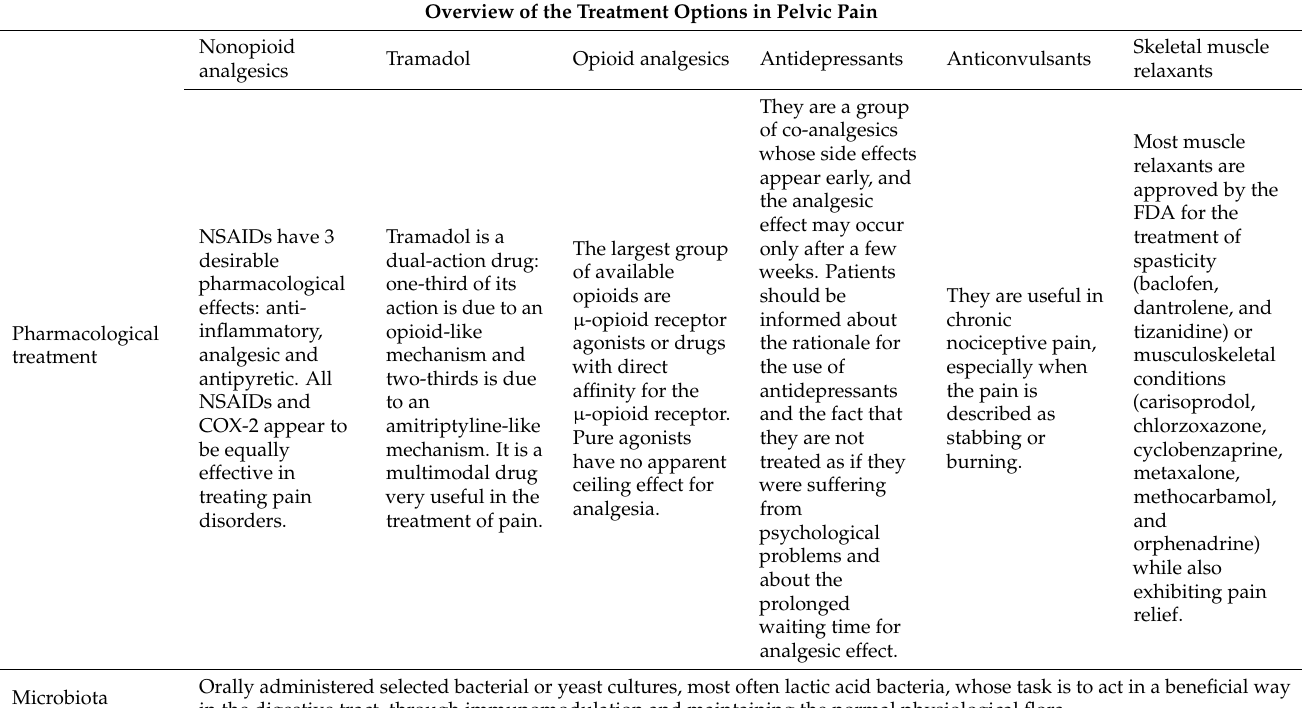
Table 1. An overview of the treatment